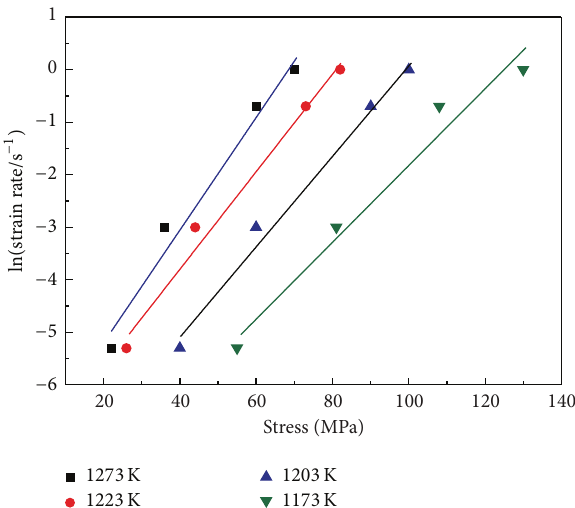
Figure 6: The relationships between ln [ sinh (𝛼𝜎)] and 1/𝑇 . and in 𝛽 region